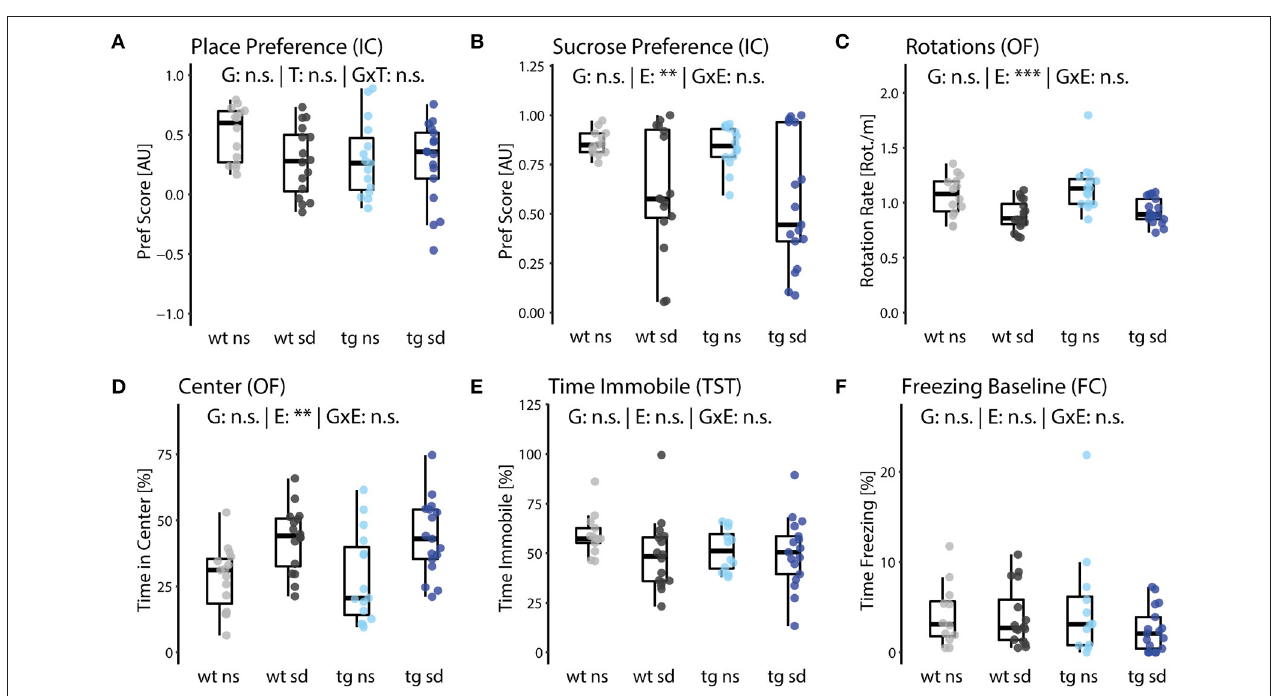
FIGURE 3 | Impact of psychosocial stress on positive and negative valence systems. (A) Positively reinforced spatial learning (place learning) in the IntelliCage showed no significant difference between groups. (B) Preference for sucrose water and (C) frequency of directional change (rotations per distance traveled) in the open field test are reduced in the sd groups of both genotypes [E: (B) F (1,49) = 12.6, p = 0.0043; (C) F (1,49) = 19.32, p = 6.8E-4]. (D) Animals of the sd groups spent relatively more time in the brightly lit center of the open field arena [E: F (1,49) = 12.5, p = 0.004]. (E) Struggling behavior measured in the tail suspension test and (F) general freezing behavior in a novel environment (fear conditioning box) did not differ between groups. Data are shown as box plots with whiskers extending to no more than 1.5-fold IQR; ** p < 0.01, *** p < 0.001, n.s., not significant; p -values are FDR-corrected and refer to Wilk’s lambda testing two-way ANOVA; n = 15/17/15/17. G, genotype term; E, environment term; G × E, interaction term.